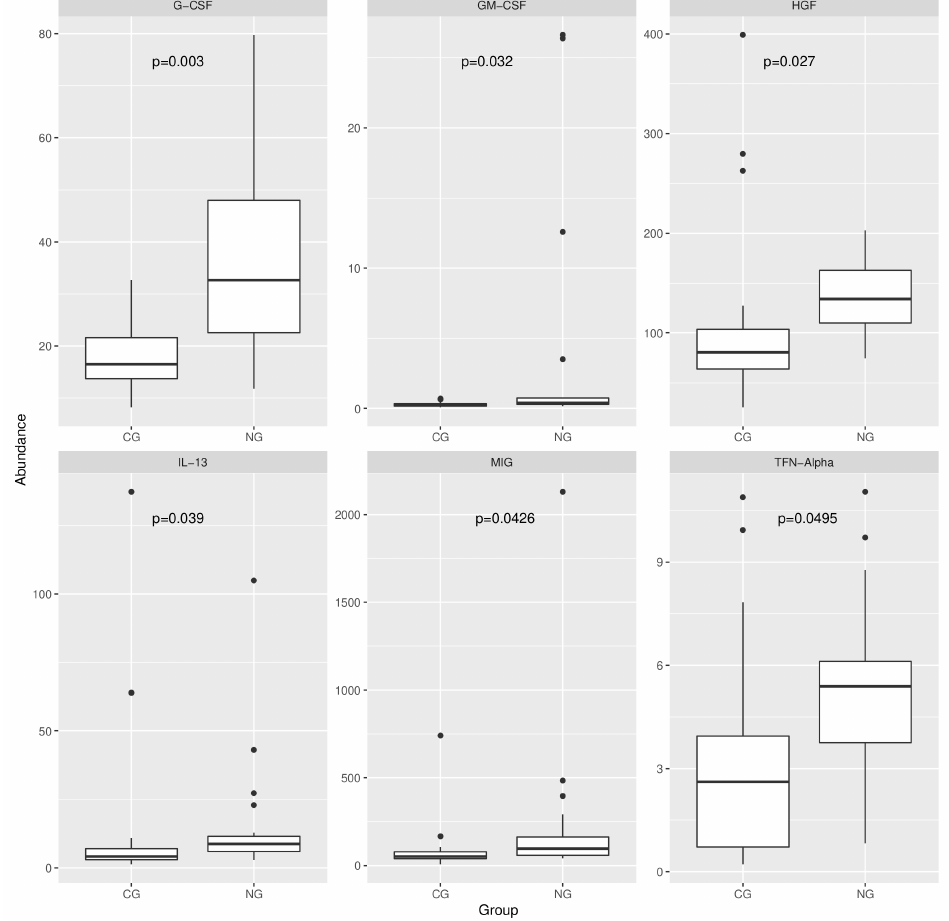
Figure 5. Box plots showing the concentration of the six proteins which are significantly differentially expressed between the NG and CG group. P-values were calculated using the Benjamini-Hochberg- corrected Mann-Whitney